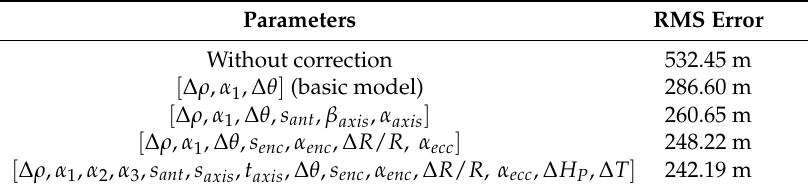
Table 2. Bias error deviation for different configuration of the model parameters.